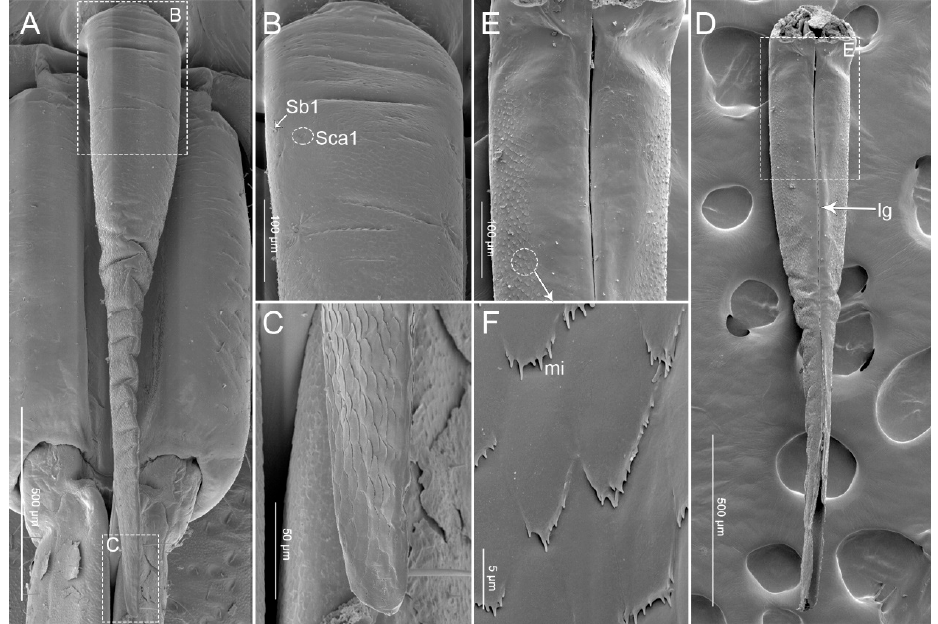
Figure 2. SEM images of labrum of Picromerus bidens . ( A ) Ventral view; ( B , C ) Enlarged view of